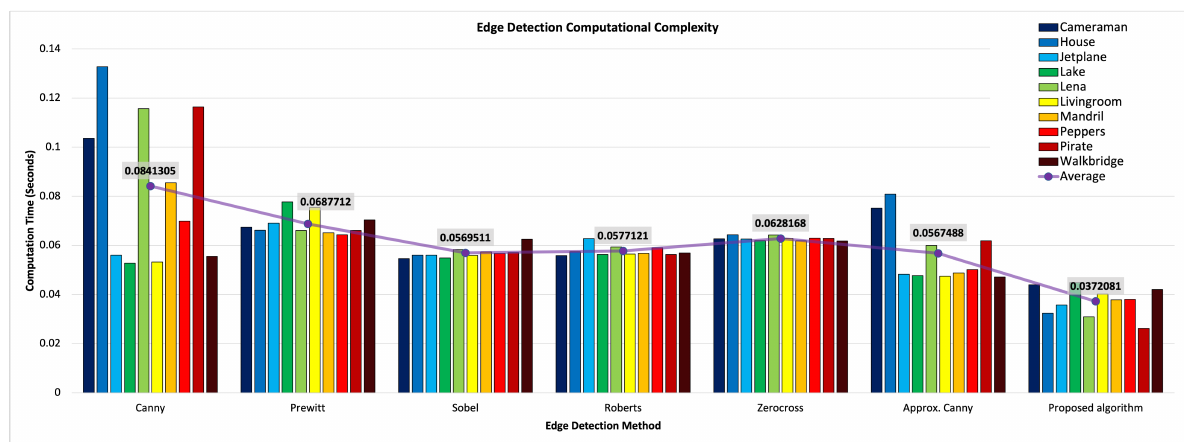
Figure 10. Average computation time for different edge detection algorithms. A dataset of ten images was used for the analysis.